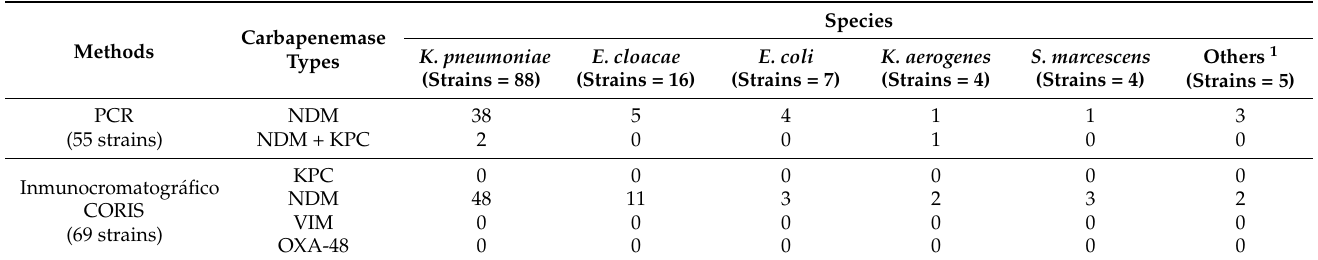
Table 1. Distribution of carbapenemase types according to methodology and bacterial species ( n = 124 isolates).